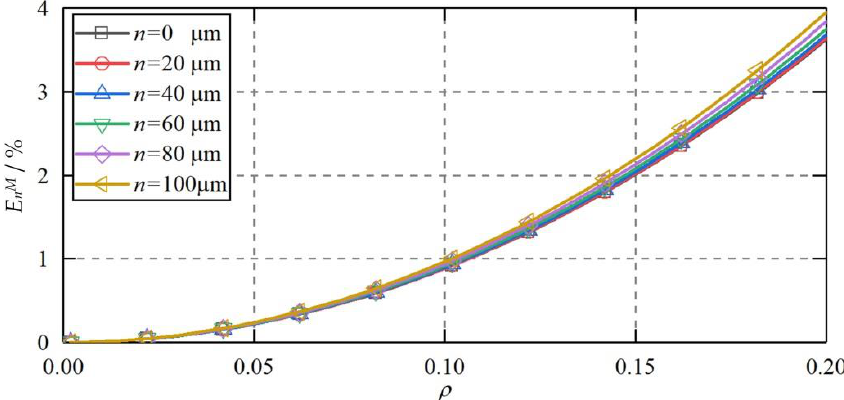
Figure 16. The theoretical capacitance error when CP S1 and CP S3 are radial offset and aligned with each other.